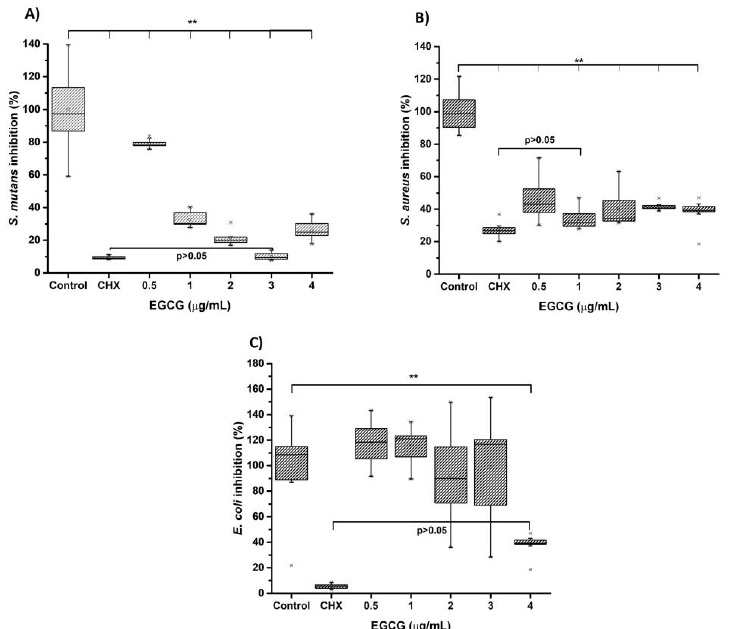
Figure 6. Antibacterial activity of EGCG with ( A ) Streptococcus mutans (ATCC 36668), ( B ) Staphylo- coccus aureus (ATCC 6538, and ( C ) Escherichia coli (ATCC 8739). The bacteria were cultivated at 0.5 on the McFarland scale. The EGCG was inoculated at different concentrations from 0 to 4 µg/mL and incubated for 24 h at 37 °C. The number of surviving bacteria was determined by MTT assay. Each value represents the mean ± SD of triplicate assays ( n = 9), * p < 0.05, ** p < 0.01 ANOVA post hoc Tukey test. Absorbances, 595 nm. EGCG = (-)- Epigallocatechin - Gallate ; ATCC = American type of cell culture; MTT = 3-[4,5-dimethylthiazol-2yl]-2,5-diphenyltetrazolium bromide; CHX = chlorhexi- dine, SD = standard deviation. Figure 7 represents the results of the SBS from the four analyzed groups. The pres- ence of EGCG at 3.12 µg/mL significantly enhances ( p < 0.01) the SBS in dentin compared with the control (17.5 ± 1.3 MPa and 15.1 ± 2.1 MPa, respectively). Meanwhile, there was no difference ( p > 0.05) in the enamel groups. The ARI did not exhibit any differences ( p > 0.05) between control groups. The most frequent failure was (50%) cohesive failure in the groups with EGCG (60%).